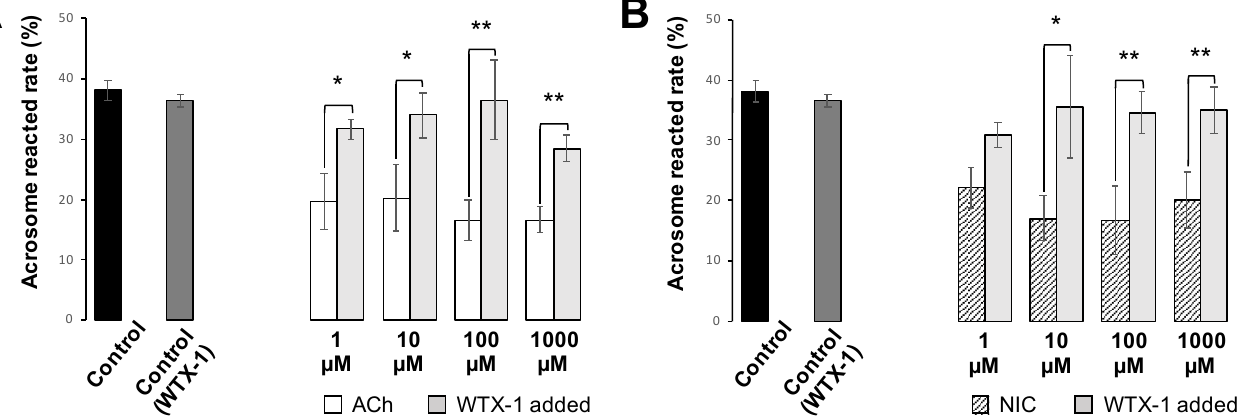
Figure 7. Effect of AChRe antagonist on sperm AR suppression caused by ACh and NIC. ( A , B ) Administration of WTX-1, an AChRe-specific antagonist, 15 min before the addition of ACh and NIC, inhibited the effects of ACh ( A ) and NIC ( B ) on AR. All the groups contained 0.1% DMSO. The experiments in Figures 6 and 7 were performed on the same day, and the data for control, ACh, and NIC treated group are the same as in Figure 6. Sperm acrosomal disappearance rates were evaluated by calculating the number of PNA-negative sperm out of the total sperm. Data shown as mean ± SD ( n = 3; * p < 0.05; ** p < 0.01).